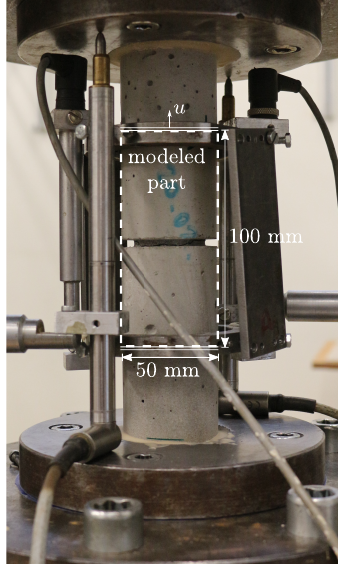
Figure 8. Experimental setup of tension test with notched cylindrical